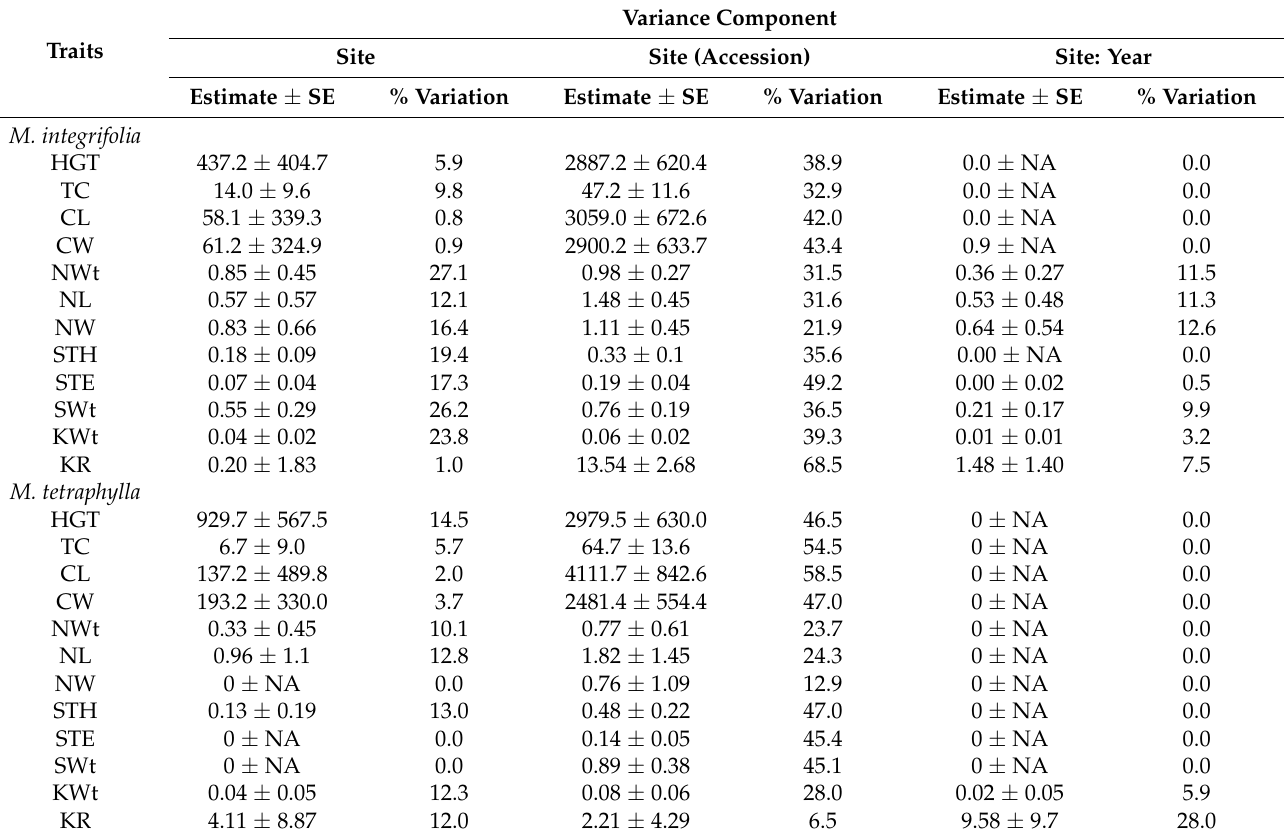
Table 4. Estimated variance components for Site, Accession within Site, and Site and Year interaction. The components of other random effects are not shown. HGT = Tree height, TC = Trunk circumference, CL = Canopy length, CW = Canopy width, NWt = Nut weight, NL = Nut length, NW = Nut width, STH = Shell thickness at hilum, STE = Shell thickness at equator, SWt = Shell weight, KWt = Kernel weight, KR = Kernel recovery. SE: standard error. NA: not